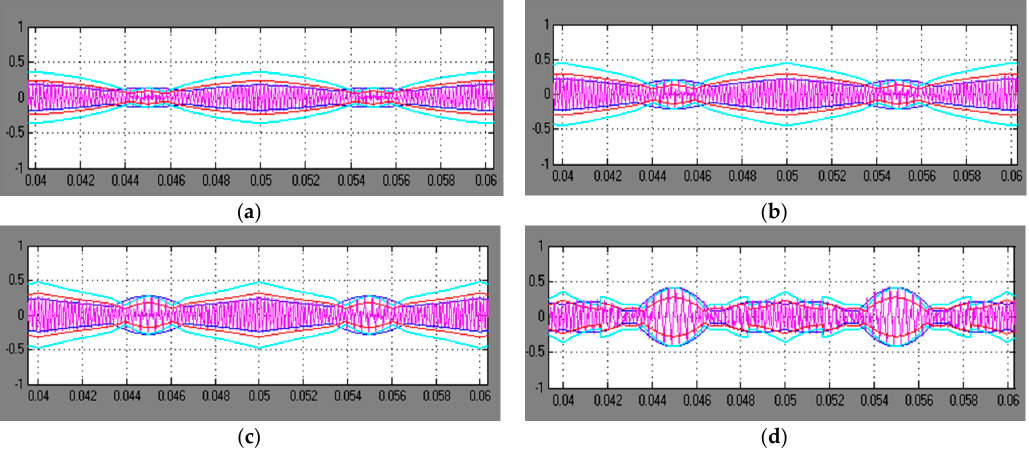
Figure 27. Experimental current ripple and theoretical envelope in the case of CPWM for: ( a ) m = 1/6; ( b ) m = 1/4; ( c ) m = 1/3; and ( d ) m = 1/2.